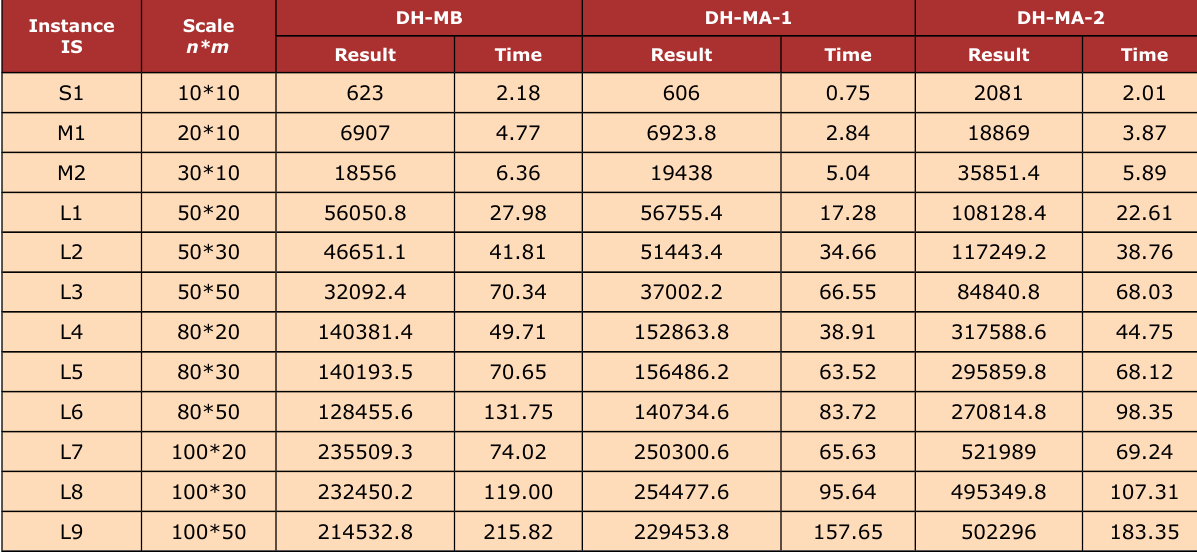
Table 3. The influence of the strategies of DH-MB to the JSP